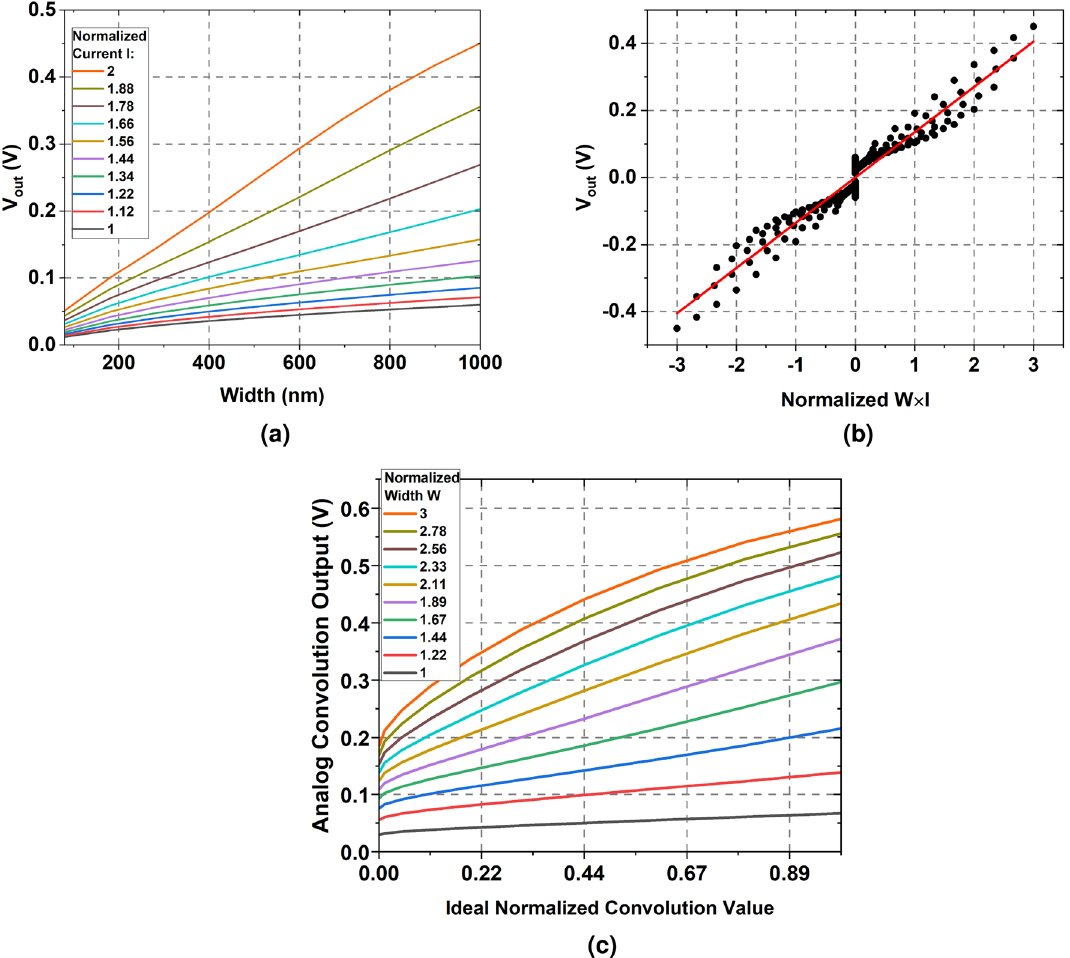
Figure 3. ( a ) Pixel output voltage as a function of weight (transistor width) and input activation (normalized photo-diode current) simulated on GlobalFoundries 22 nm FD-SOI node. As expected pixel output increases both as a function of weights and input activation. ( b ) A scatter plot comparing pixel output voltage to ideal multiplication value of